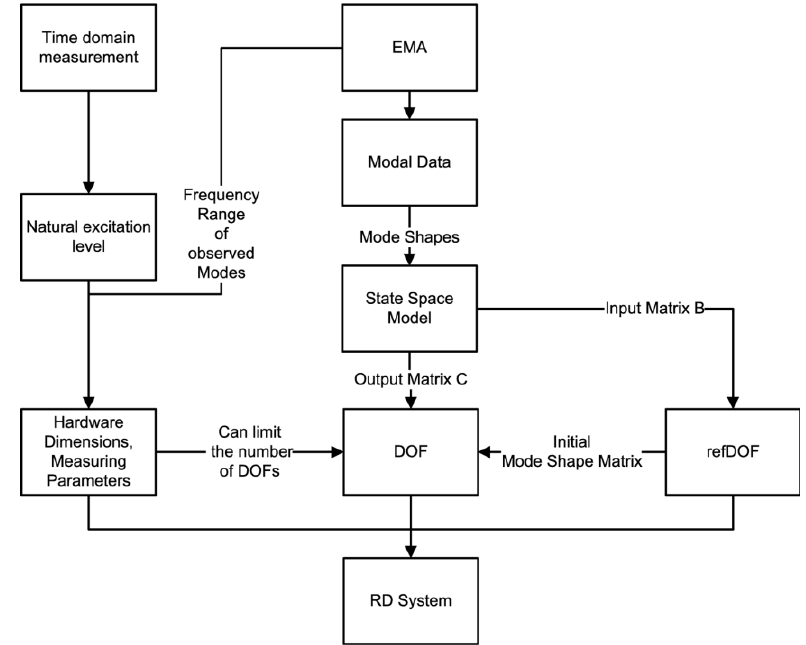
Fig. 5. Overview of the developed routine for the design of a RDM based SHM system. Table 4 contains the calculated experimental trigger levels for both reference